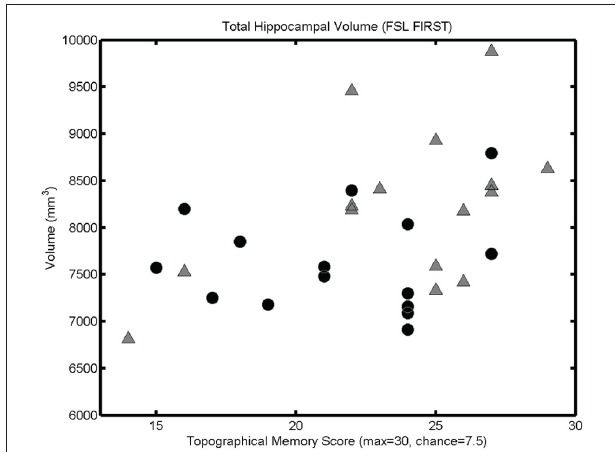
FIGURE 4 | Mesh-based segmentation results. A scattergram showing correlation between total hippocampal volume (as determined by automated mesh-based segmentation) and topographical memory scores ( r = 0 . 40, p < 0 . 05; r ♂ = 0 . 48, p < 0 . 05; r ♀ = 0 . 09, p > 0 . 05). Significant correlations are also found in each of the right and left hippocampi considered independently. to be driven largely by the men ( r ♂ = 0 . 48 p = 0 . 07, r ♀ = 0 .